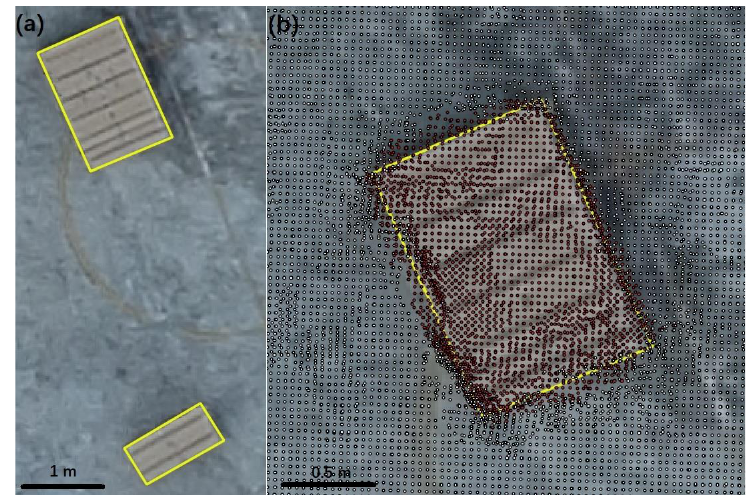
Figure 17. Accuracy was verified using box groups. ( a ) The orthomosaic and the boundaries of box groups 1 and 2. ( b ) The M3C2 results of box group 1, where the red dots indicate the values in excess of 0.15 m (box height), and the white dots indicate the values close to 0 (unchanged area). Table 3. Theoretical accuracy of the M3C2 method.